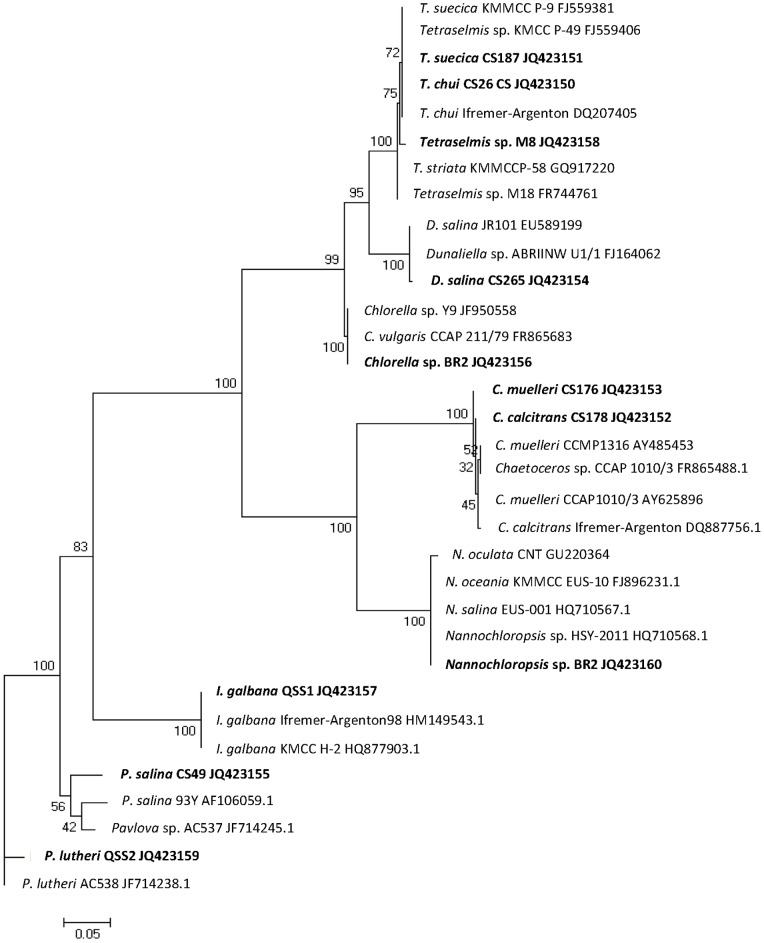
Maximum likelihood phylogenetic tree of 18S rRNA gene sequences from microalgae used in this study.Selected sequences from the NCBI database were also included (see Methods for selection criteria). Microalgae analyzed in this study are shown in bold. Numbers represent the results of 100 bootstrap replicates.